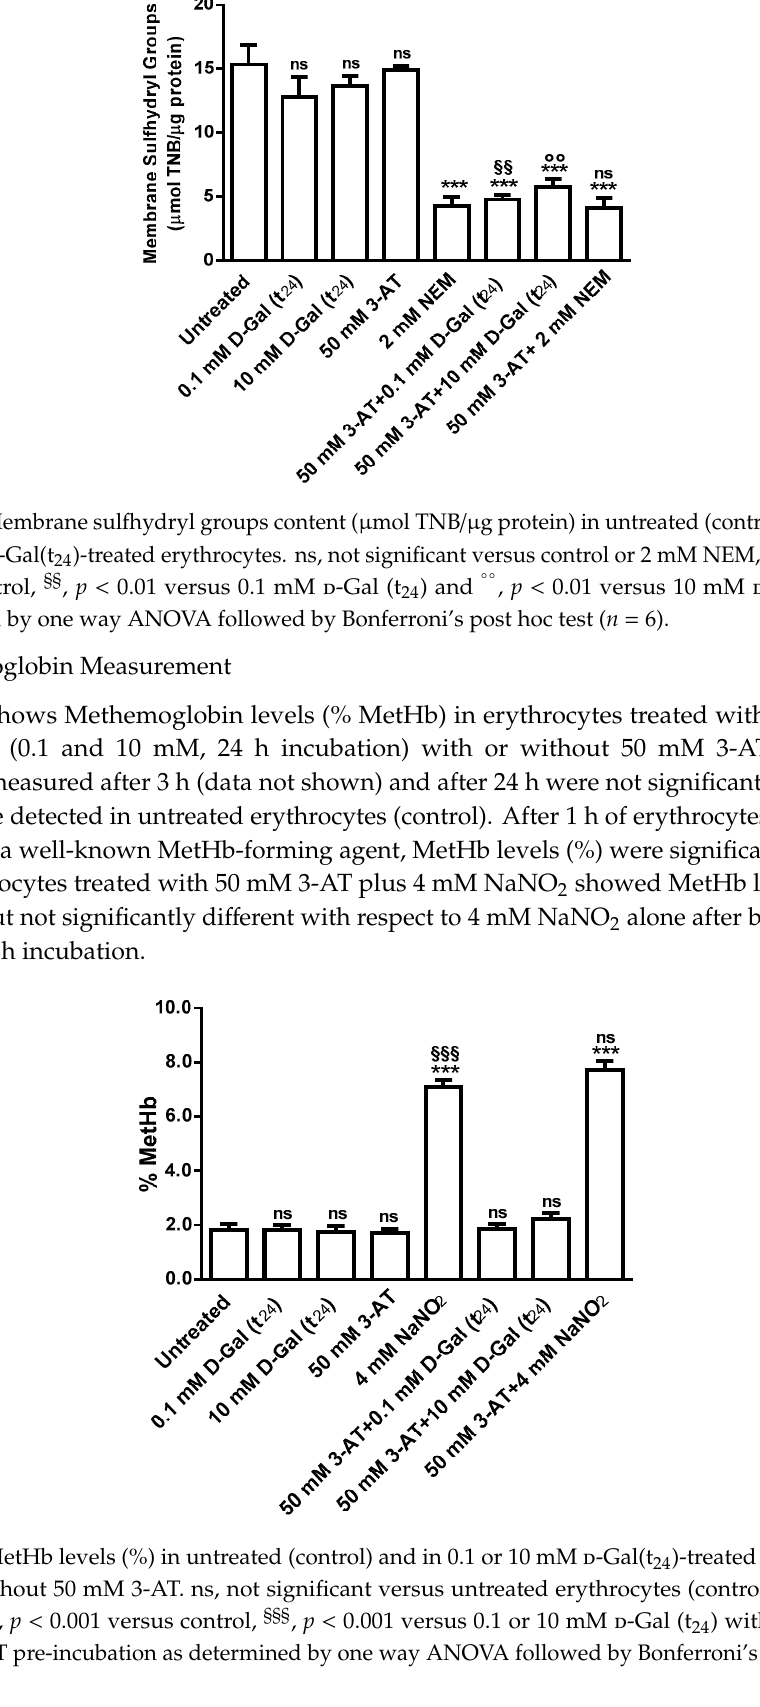
9 of 18 Figure 3. TBARS levels ( μ M) in untreated (control) and in 0.1 and 10 mM D -Gal (t 24 )-treated erythrocytes, with or without 50 mM 3-AT preincubation. ns, not significant versus control or 10 mM H 2 O 2 ; *** , p < 0.001 versus control, §§§ p < 0.001 versus 0.1 mM D -Gal (t 24 ) and °°° , p < 0.001 versus 10 mM D -Gal (t 24 ) as determined by one way ANOVA followed by Bonferroni’s post hoc test ( n = 6). 3.2.2. Membrane Sulfhydryl Groups Content Measurement Membrane sulfhydryl groups content ( μ mol TNB/ μ g protein) measured after a 3 (data not shown) and 24 h (Figure 4) incubation of erythrocytes with 0.1 or 10 mM D -Gal and in 50 mM 3-AT- incubated erythrocytes was not significantly different with respect to those measured in control. As expected, after 1 h of erythrocytes treatment with the alkylating compound NEM (2 mM), sulfhydryl